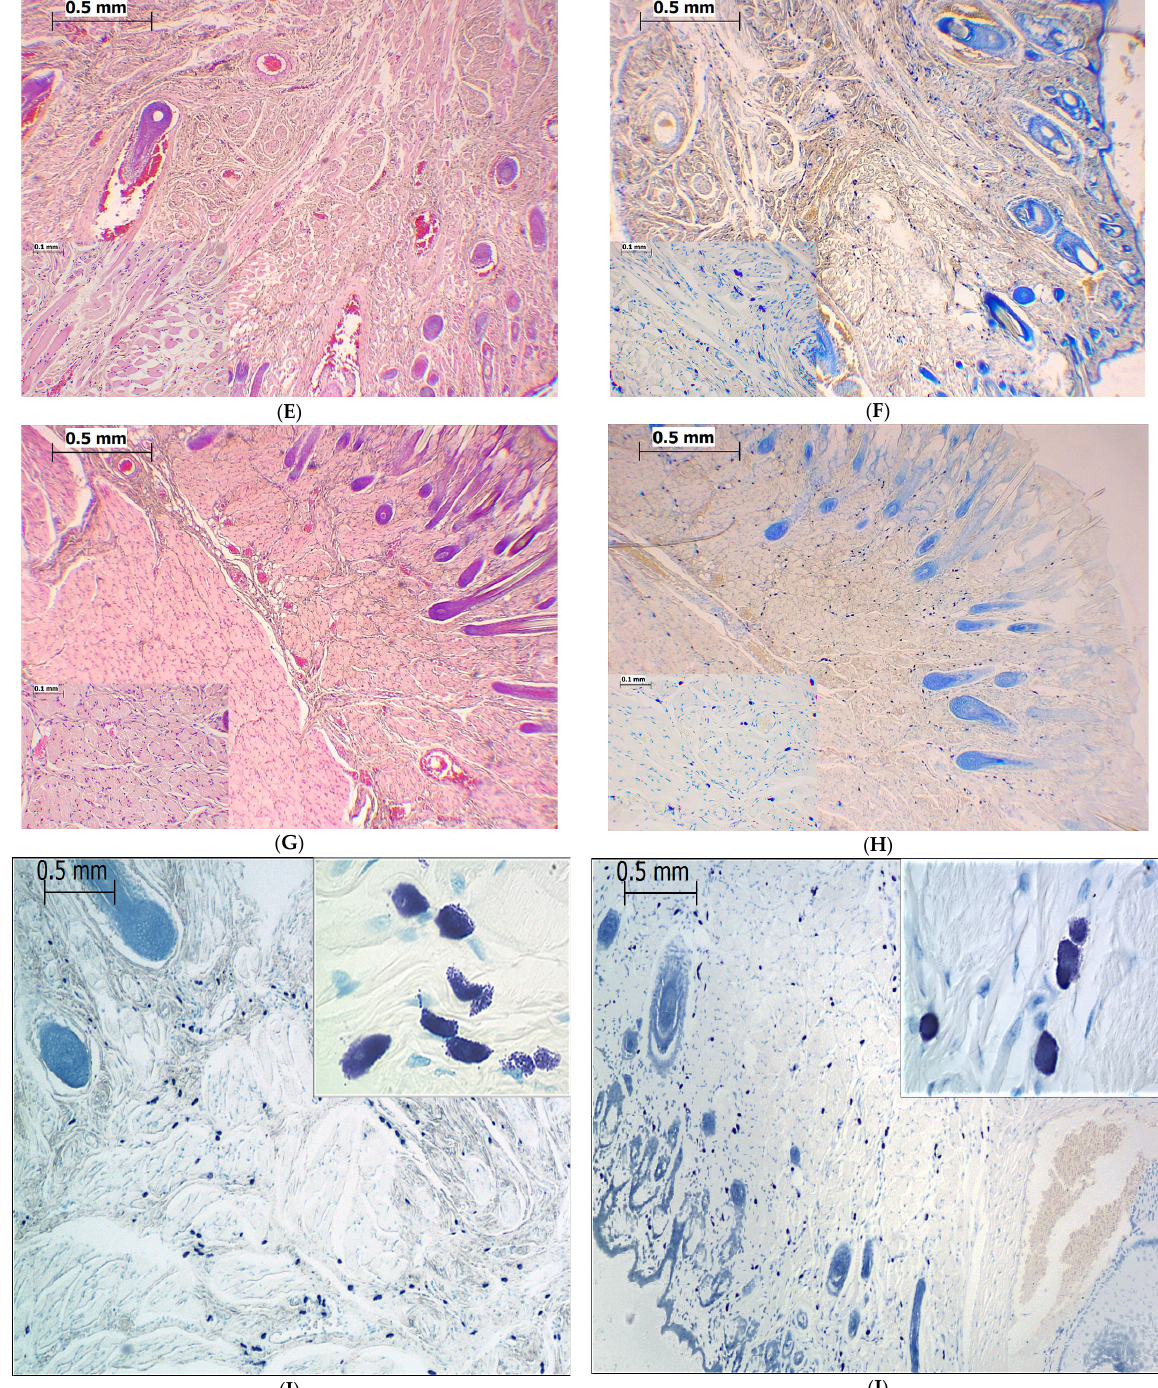
Figure 7. The effect of magnesium sulfate on morphology in the upper lip dermis in the formalin orofacial test in rats. Representative image of rat vibrissa pad histology stained with hematoxylin-eosin (HE) or toluidine blue in naive rats ( n = 6 ( A , B ) images) or 25 min after vehicle (0.9%NaCl; n = 6; ( C , D ) images), formalin ( n = 6; ( E , F ) images) and formalin + magnesium sulfate ( n = 6; ( G , H ) images) injection. Magnesium sulfate (15 mg/kg, s.c.) injected systemically 5 min before formalin; formalin (1.5%, 0.1 mL) injected s.c. to the right upper lip. Depending on group at power × 40 (big images) or × 200 magnification (small images), there are thick ( A – D images) or moderate ( E – H images) mast cell infiltrates in rat vibrissae pad tissues. Microphotographs show